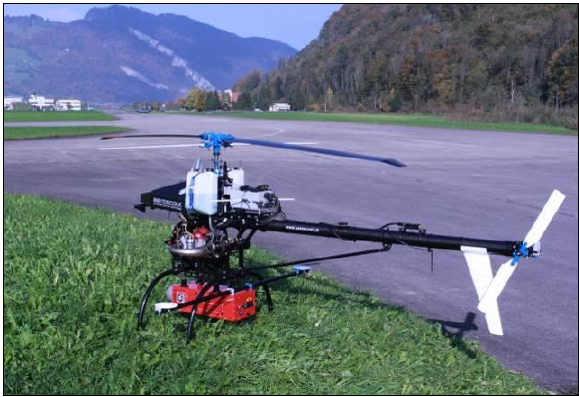
Figure 1: The Scout B1-100 UAV with the integrated laser scanning